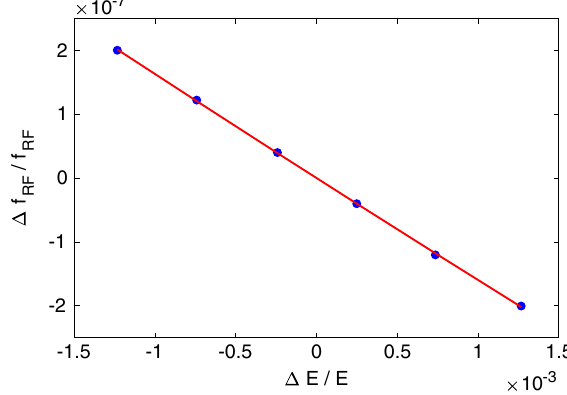
FIG. 8. Three depolarization scans to identify the main reso- nance and the sideband. FIG. 9. The relative change in the rf frequency is plotted versus the relative change in the energy, taking into account the error of the measurement. The measured data points are shown in blue, whereas a first-order polynomial fit in red is used to extract the compaction factor in good agreement with the model.